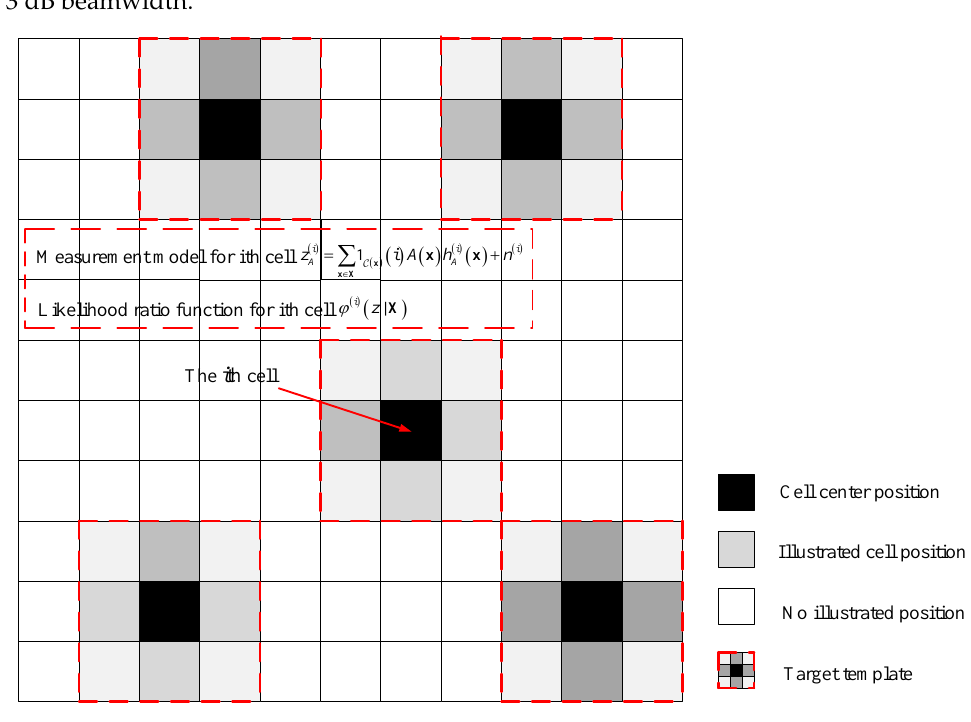
Figure 2. The illustrated template in an image pixeled TBD measurement model.